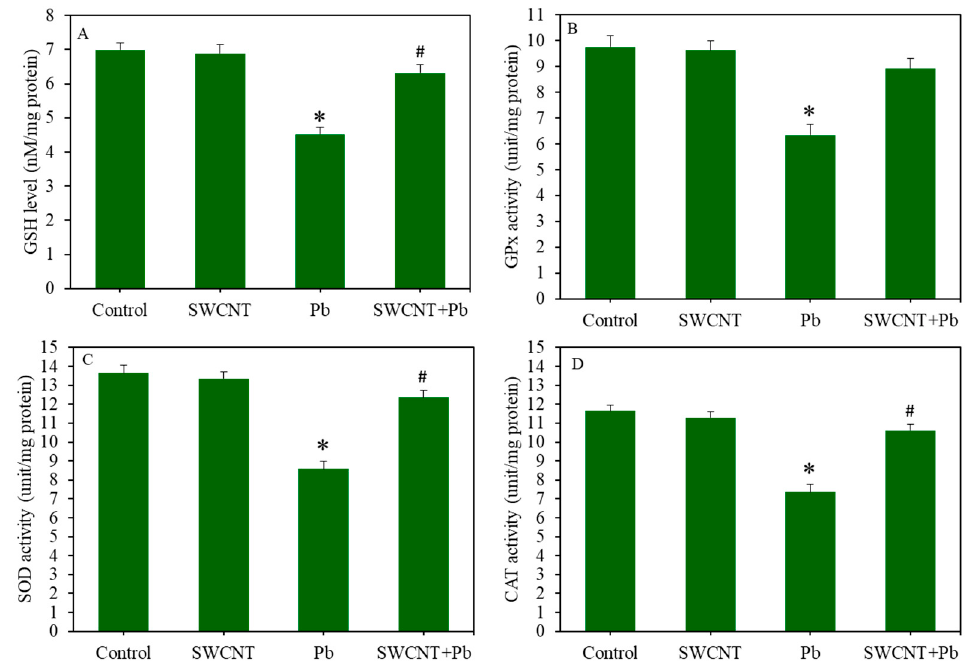
Figure 5. Antioxidant levels in A549 cells after exposure to either SWCNTs (10 µg/mL) or Pb (50 µg/mL), or co-exposure (SWCNTs + Pb) for 24 h. ( A ) Intracellular GSH level. ( B ) GPx enzyme activity. ( C ) SOD enzyme activity. ( D ) CAT enzyme activity. Quantitative data provided in this study are represented are the mean ± SD of three identical experiments made in three replicates. * Significantly different in comparison to the control ( p < 0.05). # Attenuating effects of SWCNT against Pb-induced